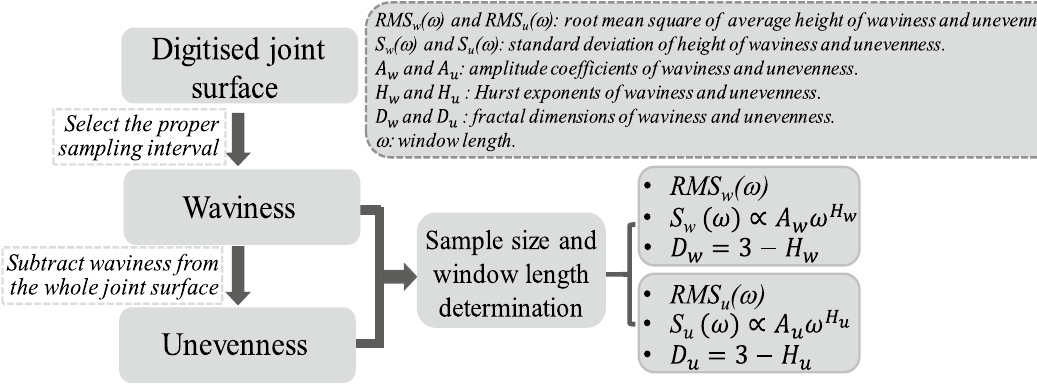
Figure 4. Flowchart to decompose roughness and fractal dimension estimation.